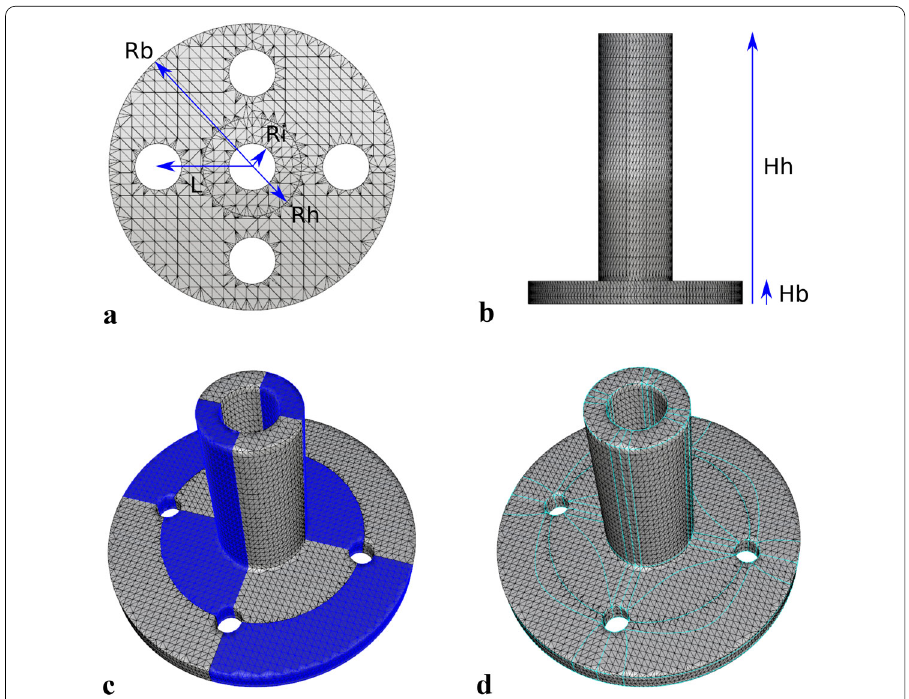
Fig. 16 Feature-aware cuboid decomposition of the casting part for geometric snapshots generation. a Radius parameters. b Height parameters. c Geometry-aware pants decomposition. d Feature-aware cuboid